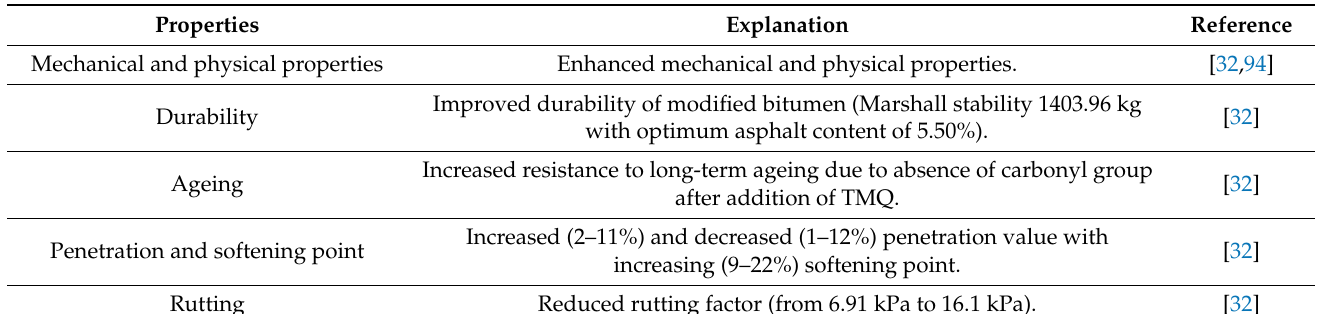
Table 21. Significant properties of TMQ